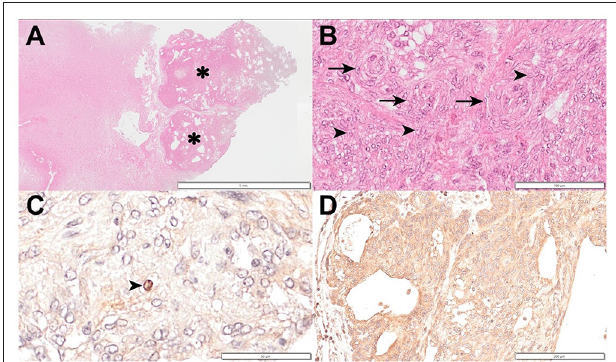
FIGURE 3 | Histopathology and immunohistochemical evaluation of a meningioma in a dog. (A) Normal brain tissue was compressed by an encapsulated neoplastic mass (asterisk). Hematoxylin and eosin; × 6 magnification; bar = 5mm. (B) Syncytial growth of round to oval meningothelial cells consisting solid sheet and meningeal whorls (arrow). Nuclei contain a clear space with prominent nucleoli (arrowhead). Hematoxylin and eosin; × 200 magnification; bar = 100 µ m. (C) A Ki67 positive cell (arrowhead) can be observed. Hematoxylin counterstain; × 400 magnification; bar = 50 µ m. (D) L-type amino acid transporter 1 stain showing strongly diffuse positive staining. Hematoxylin counterstain; × 100 magnification; bar = 200 µ